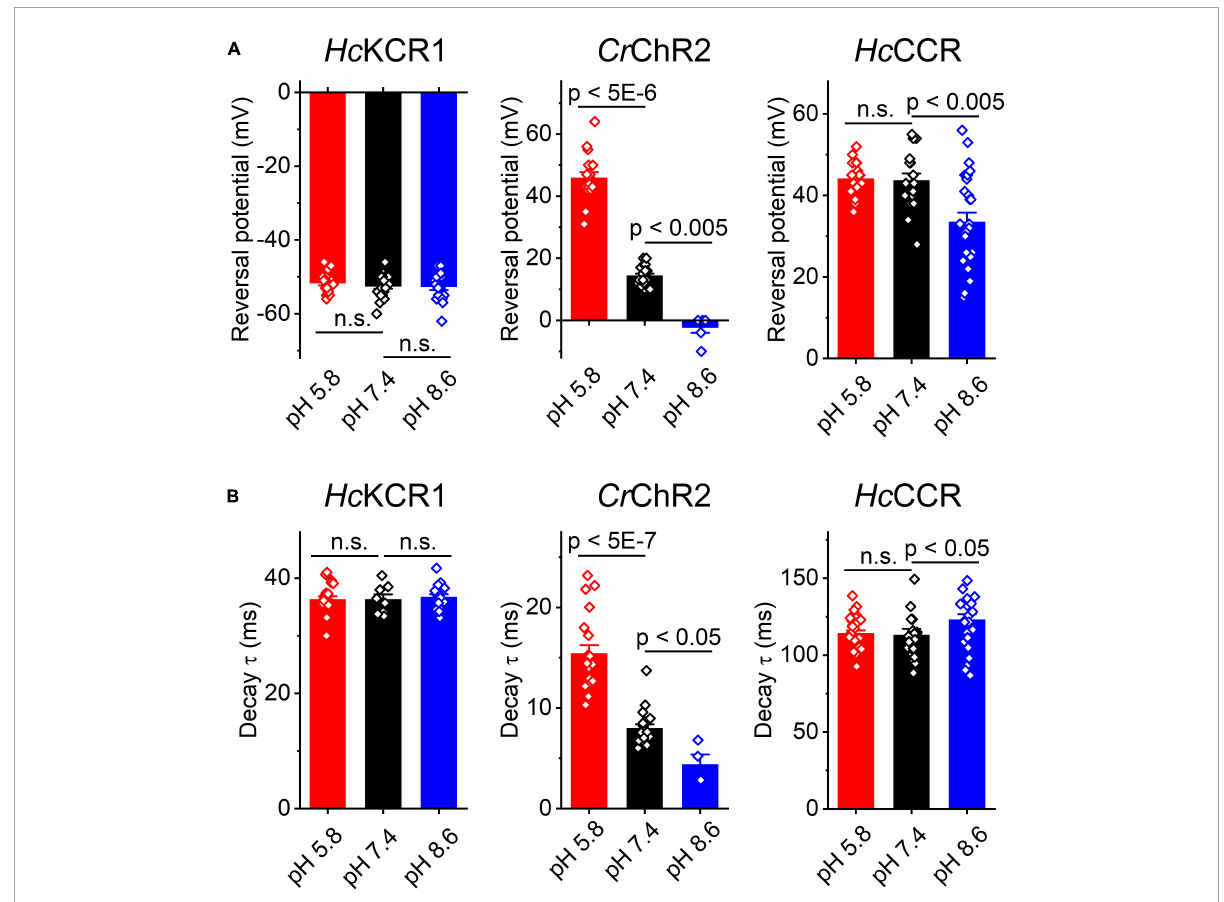
FIGURE5 The reversal potential of photocurrents (A) and the time constant ( τ ) of the main (fast) component of photocurrent decay (B) in Hc KCR1, Cr ChR2 and Hc CCR measured at the indicated external pH. The bars are mean ± sem, the circles are the data from individual cells. Numerical data and full statistical analysis are provided in Supplementary Datasheet 2